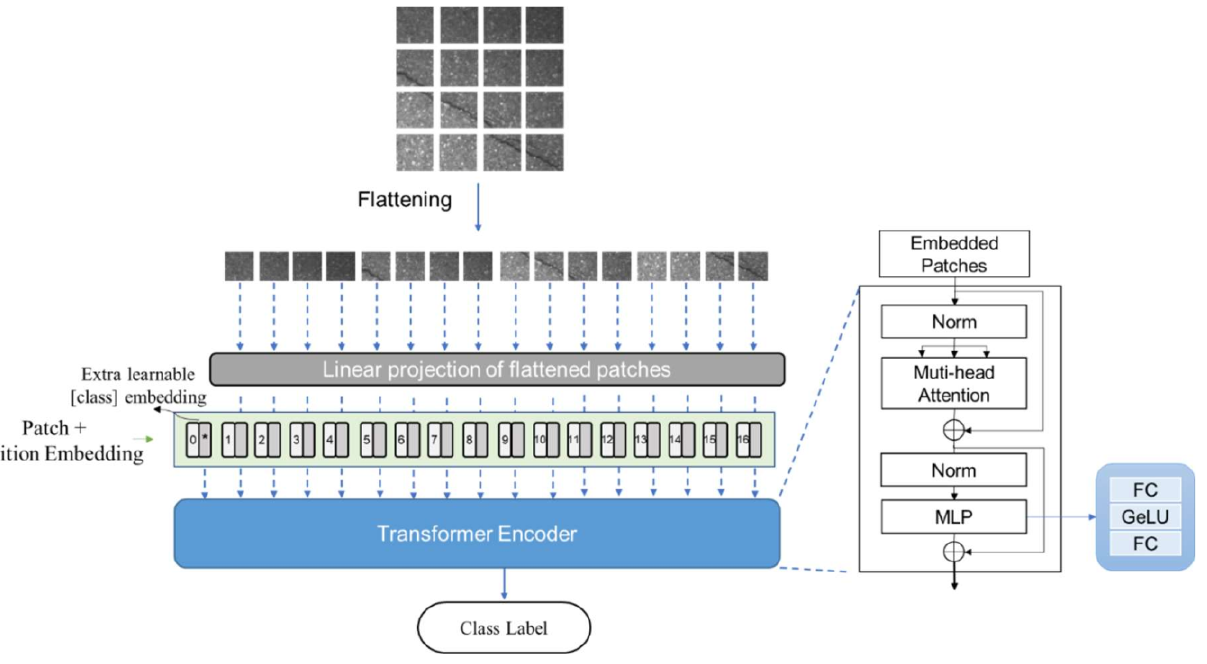
Figure 5. Structure of Vision Transformer